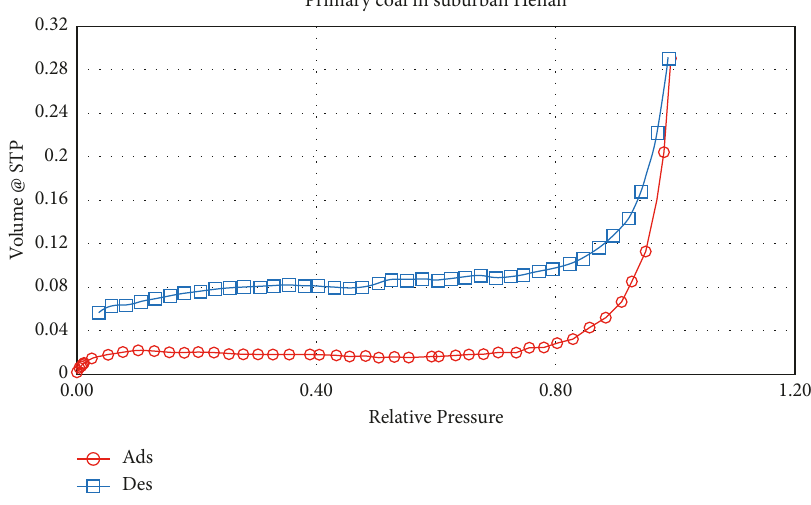
Figure 11: Adsorption and desorption curves of